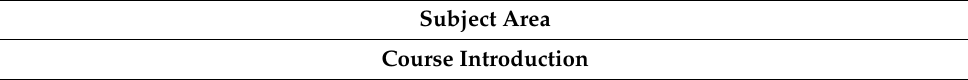
Table 1. Passenger ship crowd management training subject